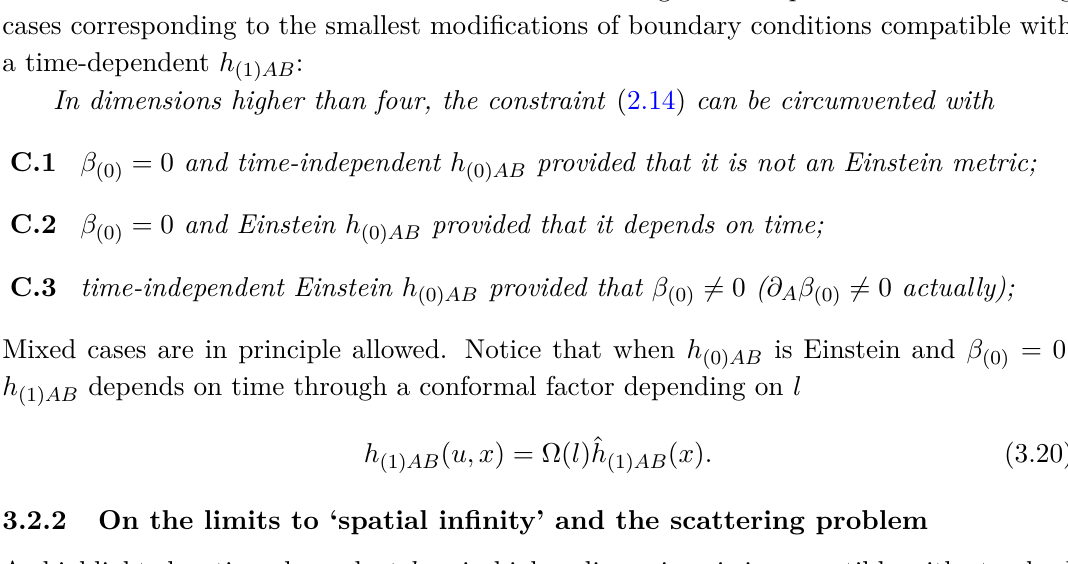
Table 2 . Various boundary data compatible with ∂ u h can also be obtained from this under appropriate